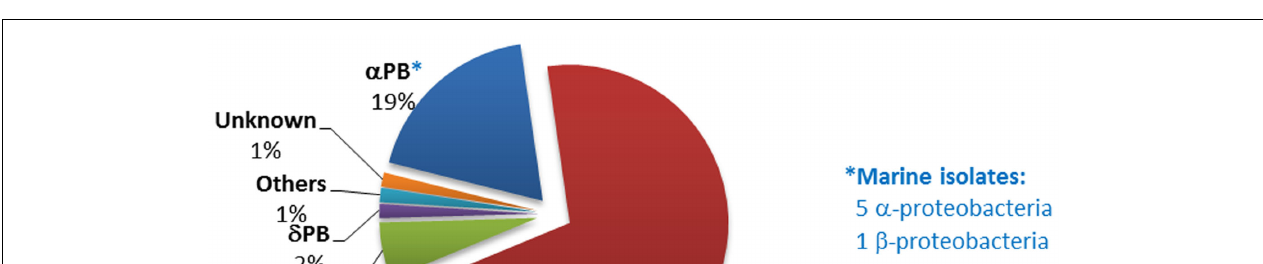
the phnX gene, out of the 190 sequenced marine bacterial genomes publically available, are indicated to the right of the Figure.